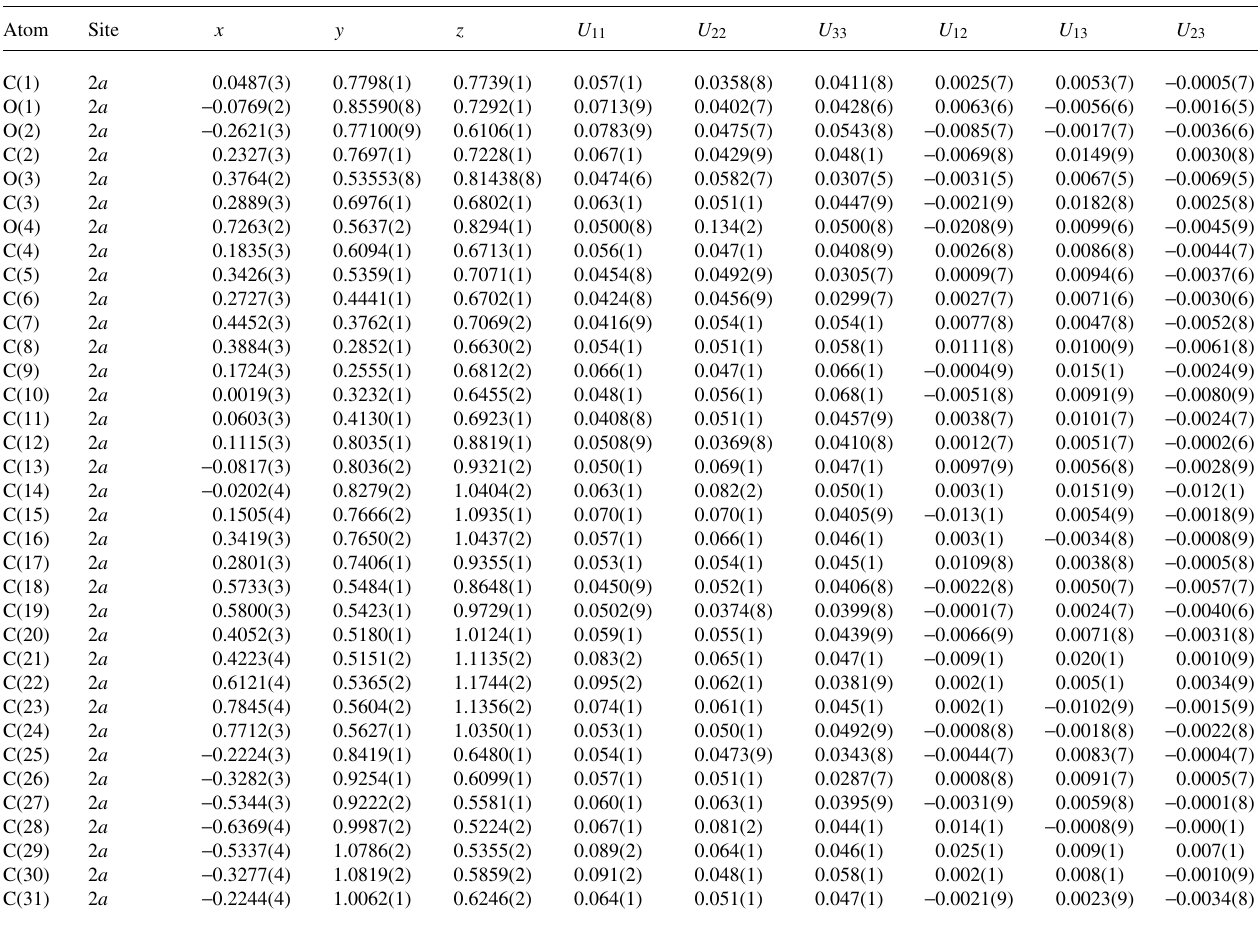
Table 3. Atomic coordinates and displacement parameters (in Å 2 ) .